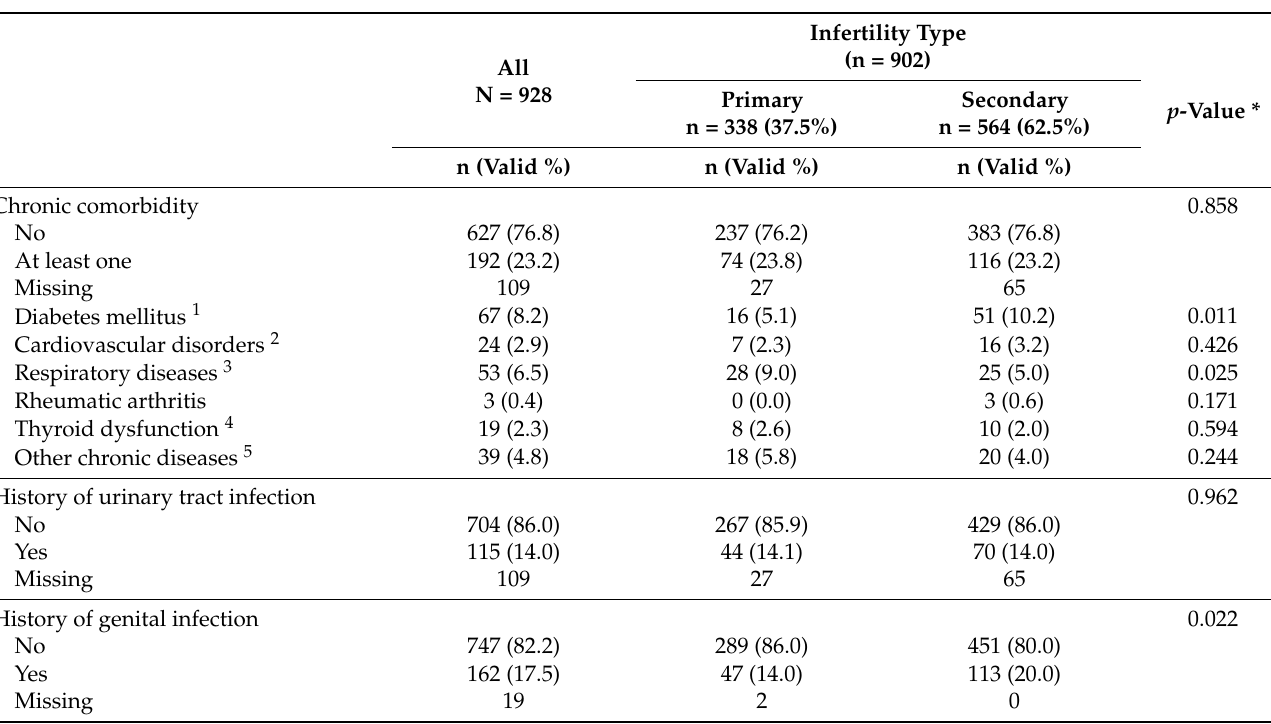
Table 3. Medical characteristics of fertility clinic attendees, and the distribution between primary and secondary